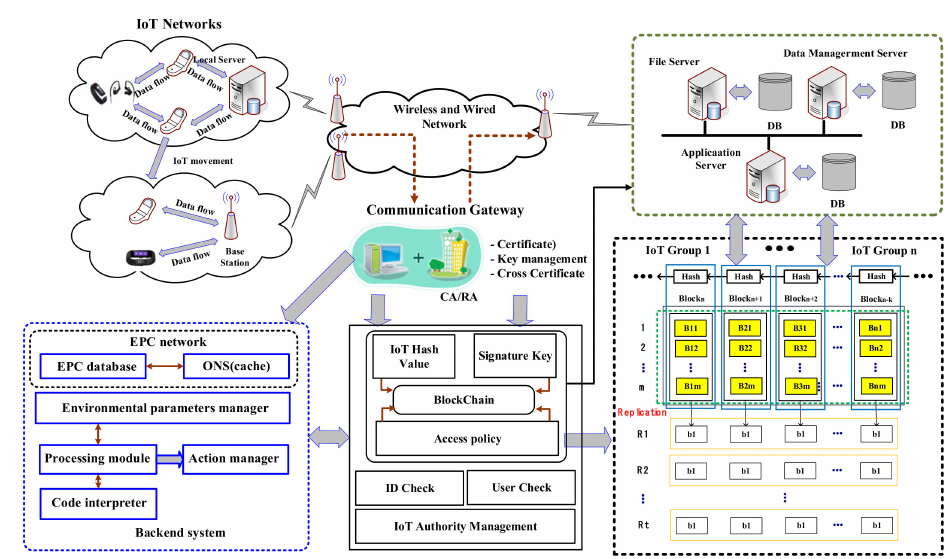
Figure 2. IoT data operation process of proposed technique.